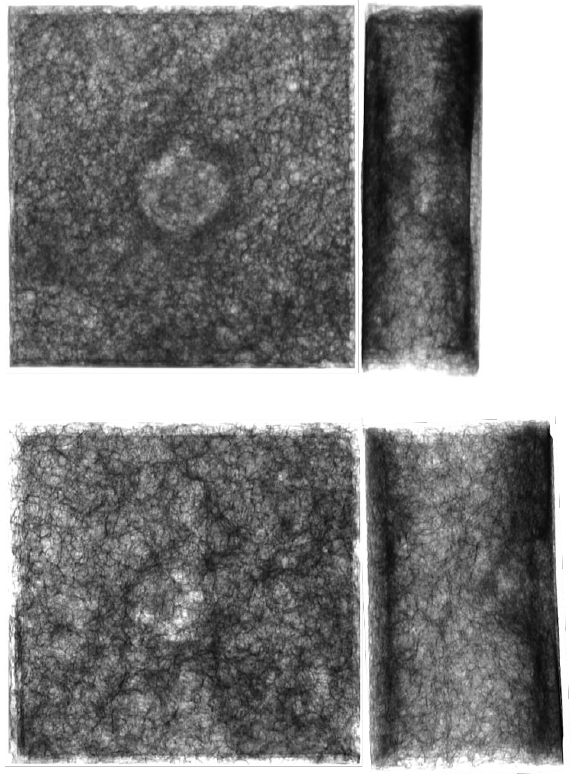
Figure 11. Radiographic images for Type I ( upper ) and Type II ( below ) AF specimens subjected to an energy impact of 35 J. an energy impact of 35